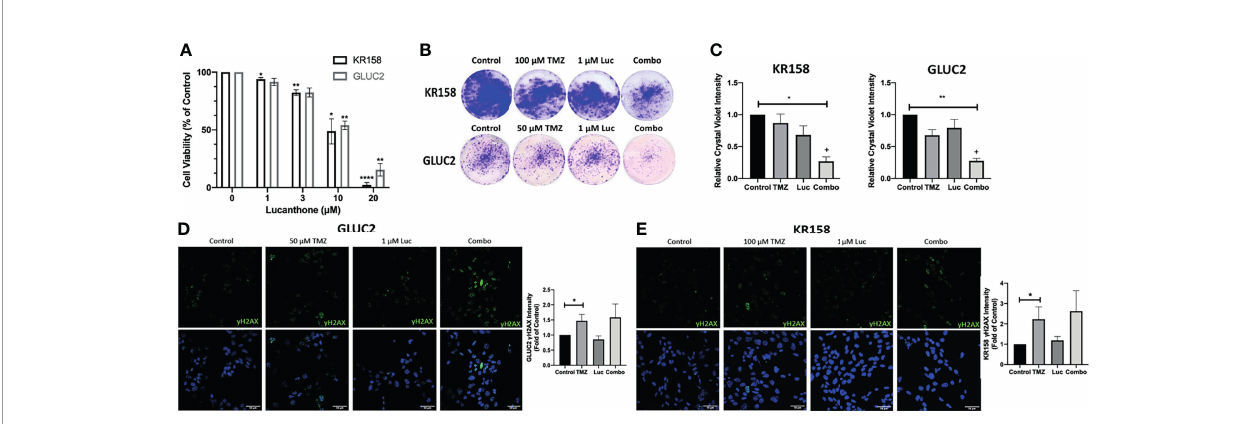
FIGURE 2 | Interaction between lucanthone and temozolomide. (A) KR158 and GLUC2 cells were treated with Lucanthone for 72 hours, after which an MTT assay was performed. Bars are mean +/- SEM, N=3-7 independent experiment. ANOVA p<0.0001. *p < 0.05, **p < 0.01, ****p < 0.0001, Dunnett ’ s multiple comparison test to control-treated cells. (B, C) KR158 and GLUC2 cells were treated with lucanthone, TMZ, or the combination for 4 days and then allowed to recover in drug- free medium for 3 days. The cells were PFA- fi xed and stained with crystal violet. Crystal violet-stained cells were then lysed and relative absorbance was measured to approximate culture viability. Representative wells are shown in (B) . (C) Quanti fi cation of crystal-violet stained cultures. Bars are mean +/- SEM, N=3-4 independent experiments. *p < 0.05, **p < 0.01, Dunnett ’ s multiple comparison test to control-treated cells. +p < 0.05, King ’ s synergy test, demonstrating signi fi cant interactions between lucanthone and TMZ in both cell lines. (D) Representative micrographs of g H2AX stained GLUC2 cells and quanti fi cation of g H2AX intensity per number of cells in the fi eld of view in experiments where the GLUC2 cells were incubated with TMZ, or the combination of lucanthone and TMZ. (E) Representative micrographs of g H2AX stained KR158 cells. Quanti fi cation of g H2AX intensity per number of cells in the fi eld of view in experiments where the KR158 cells were incubated with TMZ, or the combination of lucanthone and TMZ. Bars are mean +/- SEM, N=4 independent experiments. *p < 0.05, Mann-Whitney